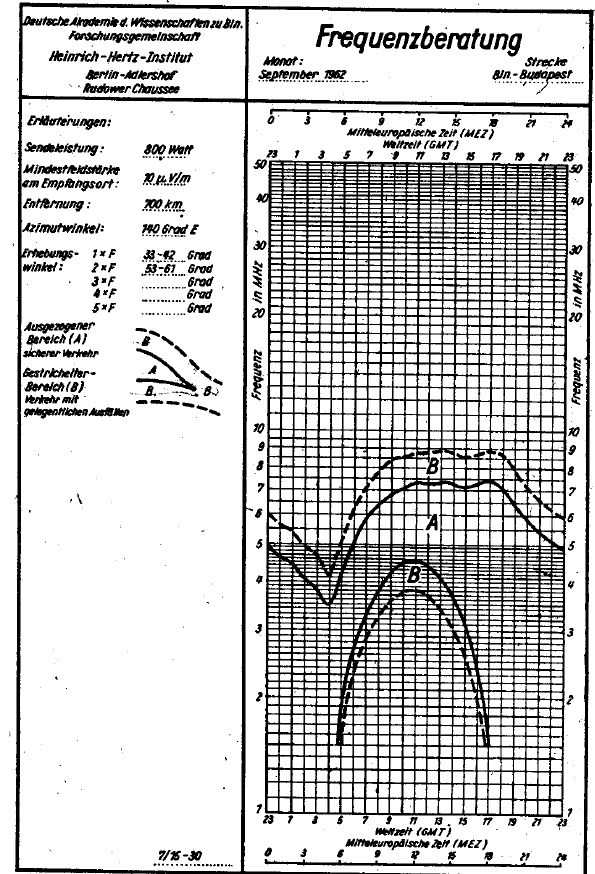
Figure 18. An example of forecast, issued by HHI, for short-wave communication between Berlin and Budapest for September